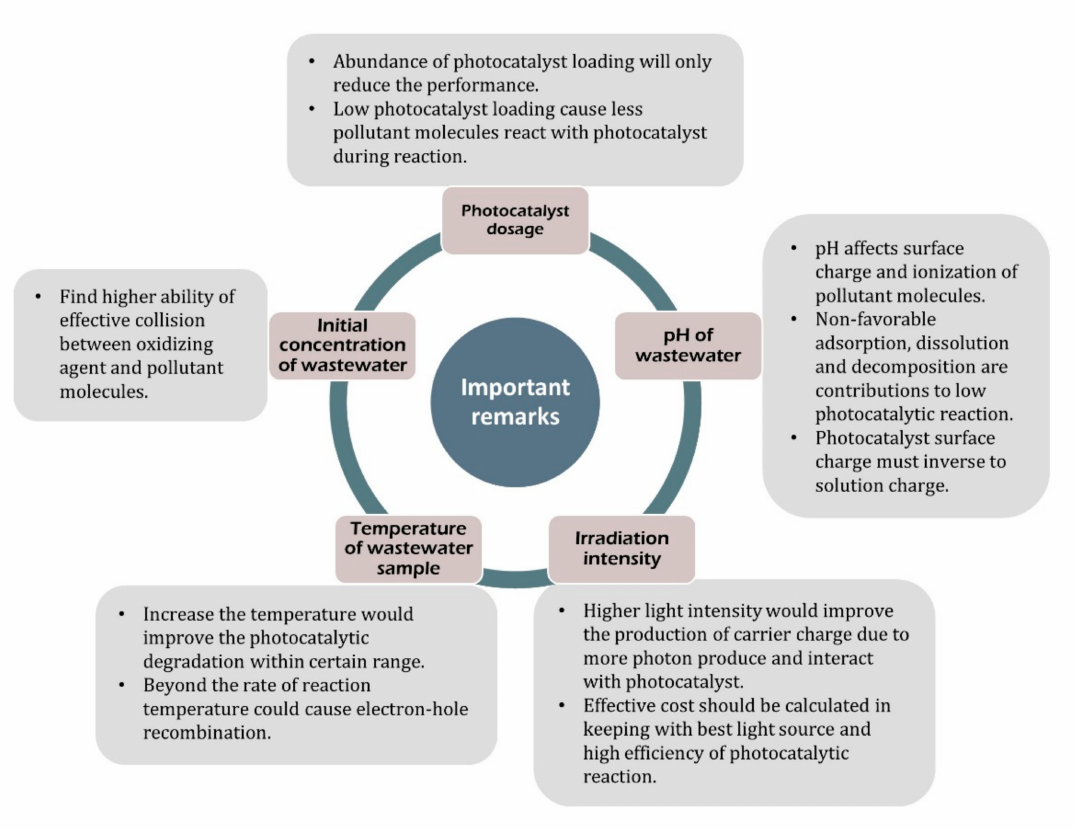
Figure 18. Important remarks: Parameter e ff ects on photocatalytic degradation e ffi